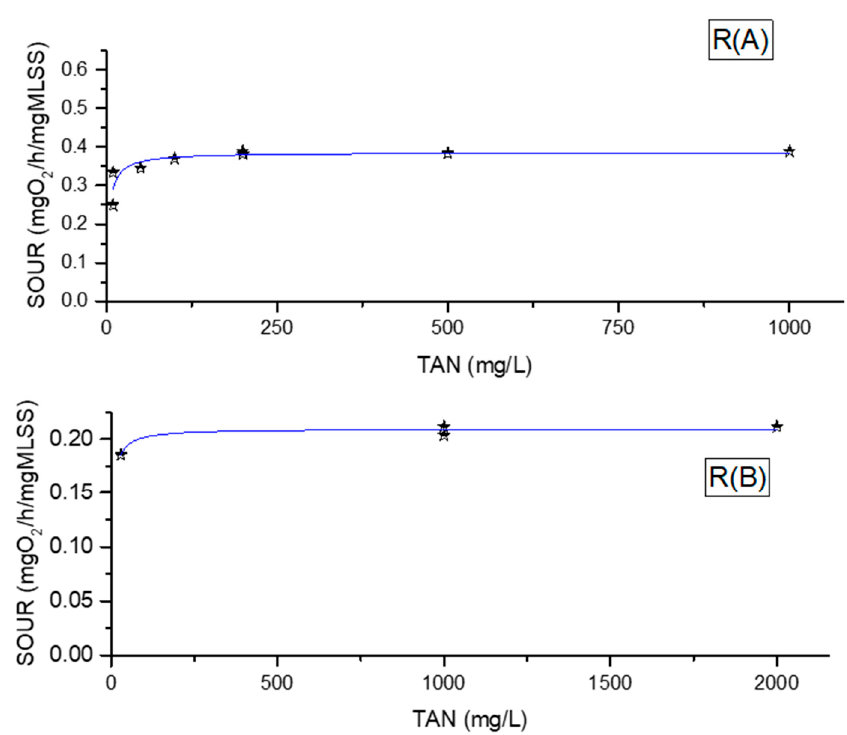
Figure 4. Specific oxygen uptake rate (SOUR) estimated from CSTR daily profile data and Monod model Equation (9) was fitted.